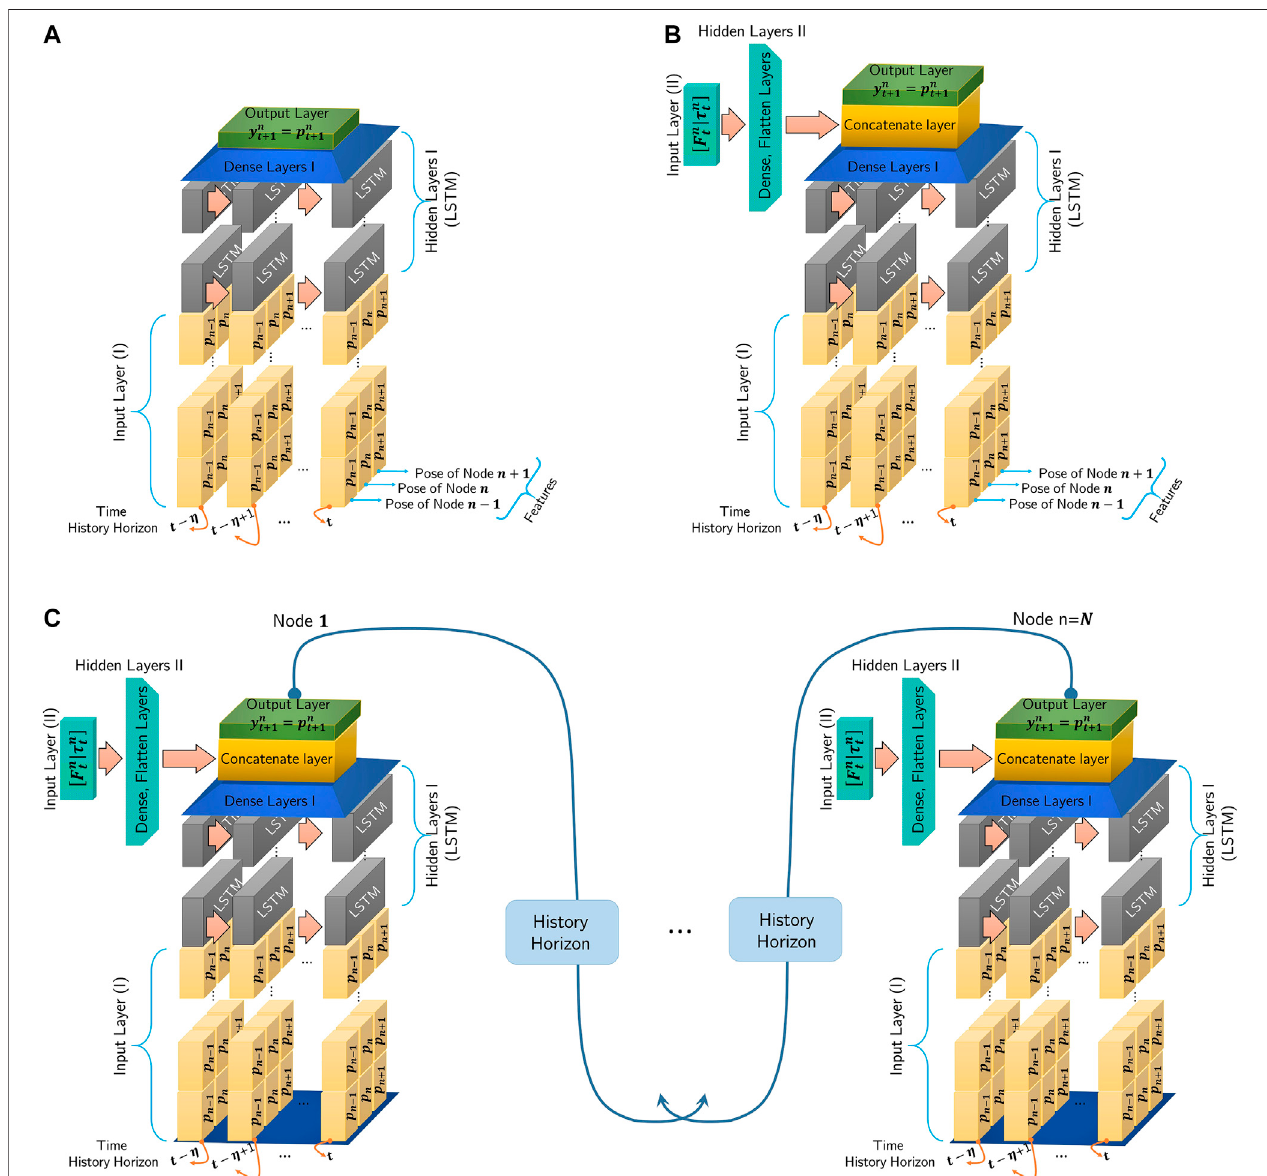
FIGURE 2 | Recurrent Neural Network-based model, length of the time history horizon is determined by η and features composed of adjacent nodes pose: (A) : PosesofNodes n − 1, n ,and n + 1aretheinputlayerandnoforcesortorquesareappliedtothenode. (B) :The fi rstinputlayeriscomposedofposes p n − 1 , p n ,and p n + 1 at time history horizon [ t − η , t − η + 1 , ... , t ] and the second input layer includes forces and torques [ F n t , τ n t ] T which are incorporated into the model through the Hidden Layers II (dense and fl atten layers). (C) : Proposed RNN-based models of the continuum manipulator with N nodes including Input, Hidden, and Output Layers. A history of each node output is used as an input for adjacent nodes. Nodes poses (Input Layer I) and forces and torques (Input Layer II) through the Hidden layers I and II are proceed and concatenated